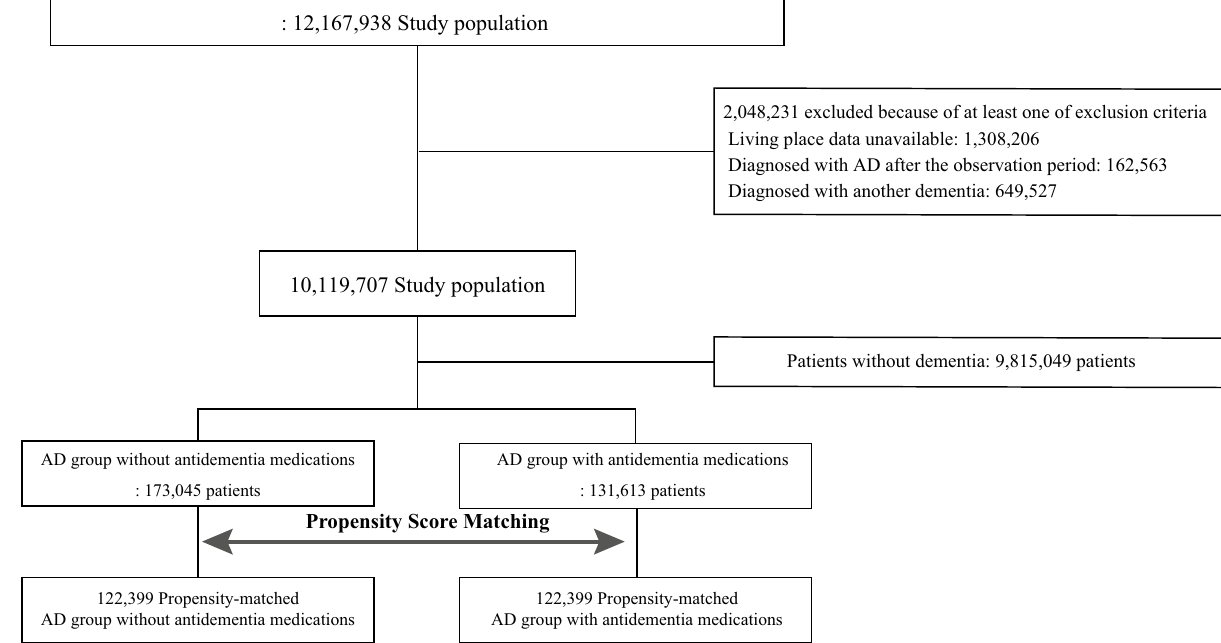
Figure 1. Flow diagram for the patient selection. Flowchart showing how cases and controls were selected from the nationwide health insurance claims database of Japan. AD Alzheimer’s dementia. *Newly registered as the first medical claim since turning 65 years